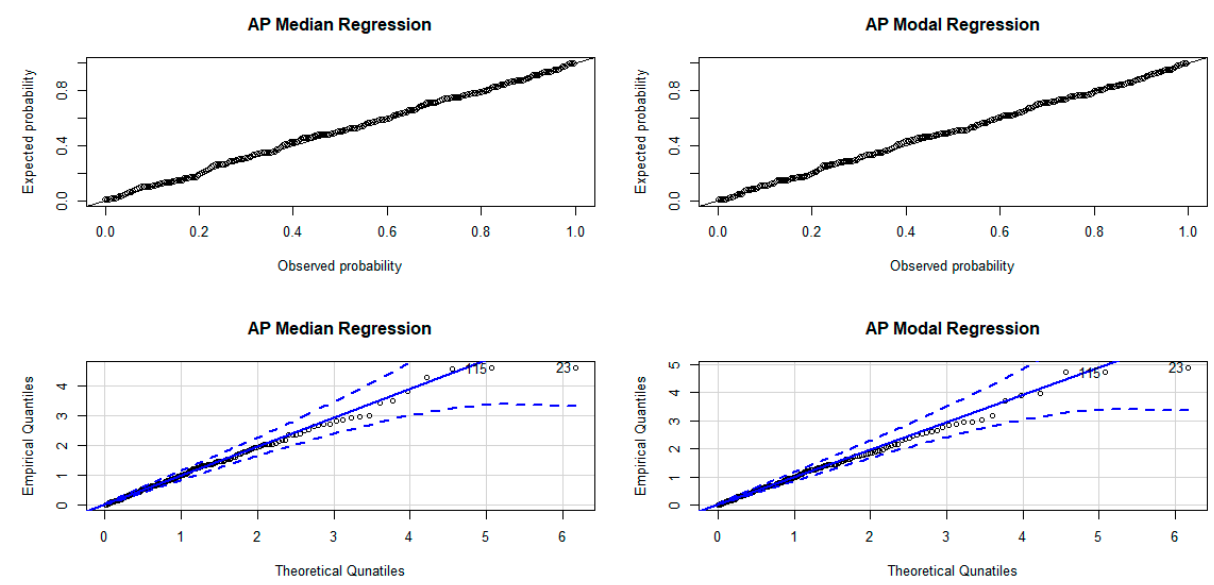
Figure 15. P-P ( top ) and Q-Q ( bottom ) plots of the Cox–Snell